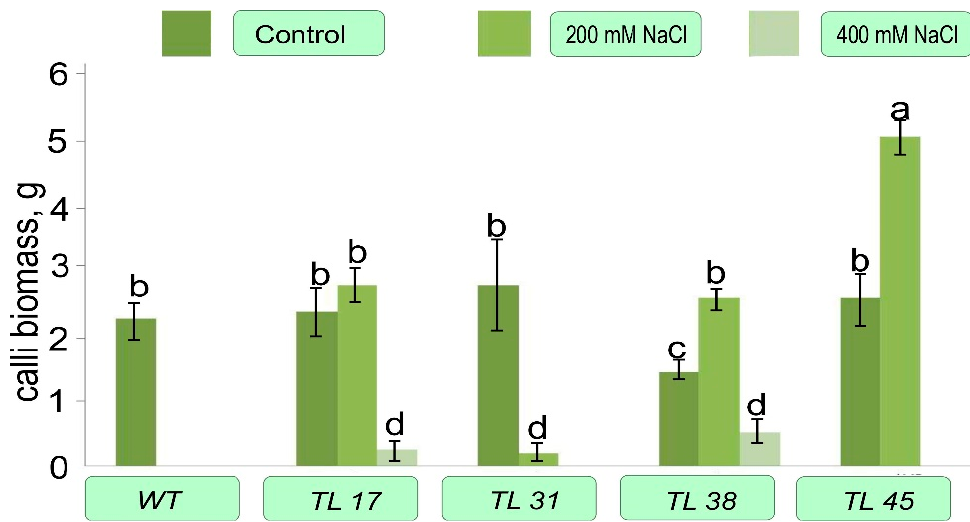
Figure 5. Callus formation ability in codA transgenic tobacco lines. The explants were cultured for 24 days on the Tc medium in the dark with a constant temperature of 25 °C and then 5 calli were weighed from each of the Petri dishes. Control medium Tc without the addition of increased concentrations of NaCl, 200—Tc medium with the addition of 200 mM NaCl, 400—Tc medium supplemented with 400 mM NaCl. Columns with the same letters are not significantly different ( p ≤ 0.05, Duncan’s test).